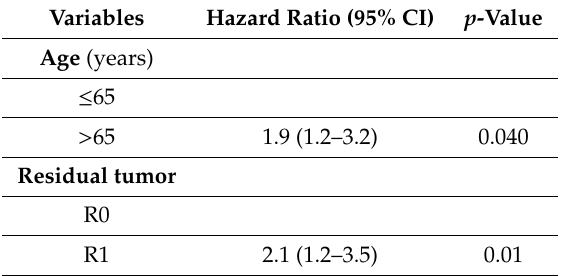
Table 5. Multivariate survival analysis—Cox model—overall survival ( n = 95